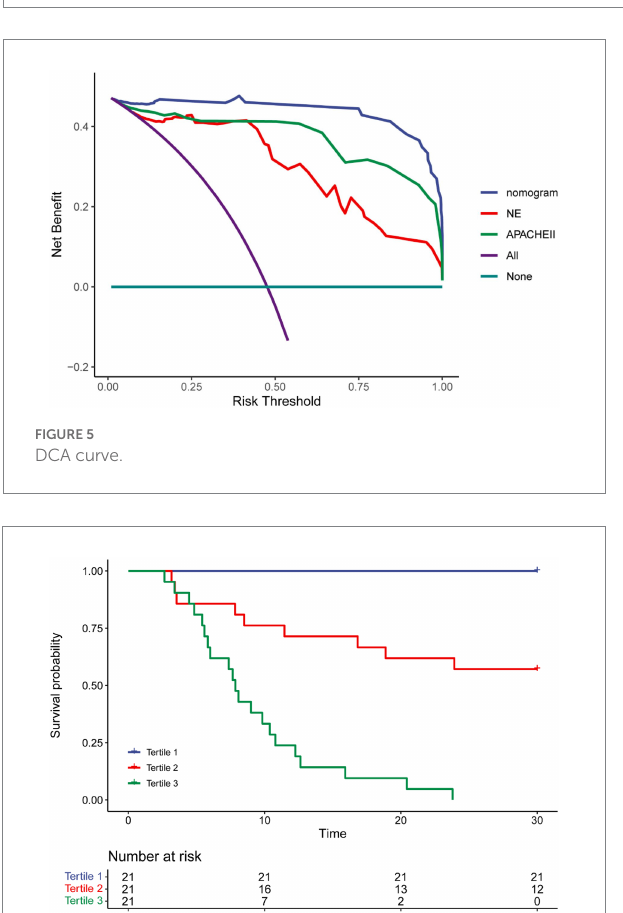
FIGURE 4 Calibration curve.